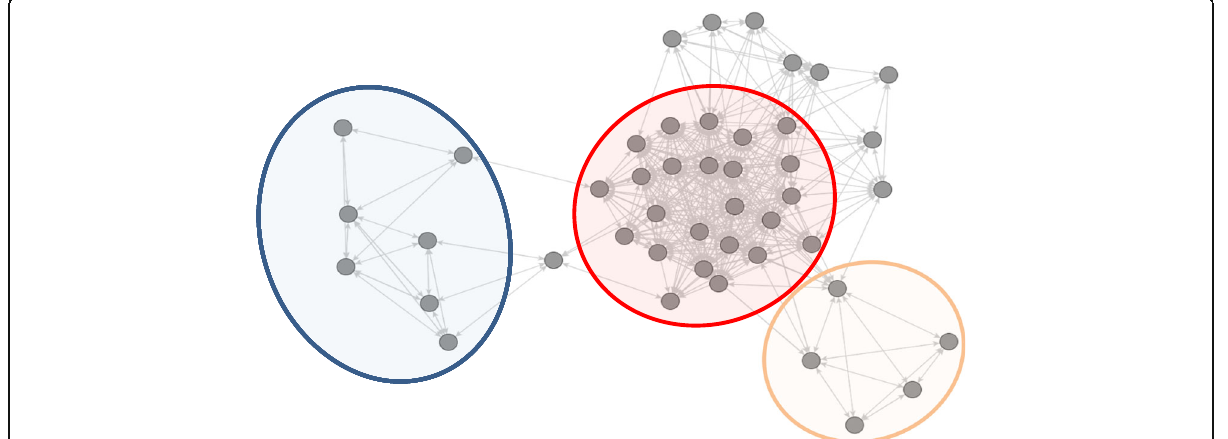
Fig. 1 Personal network with representation of different social